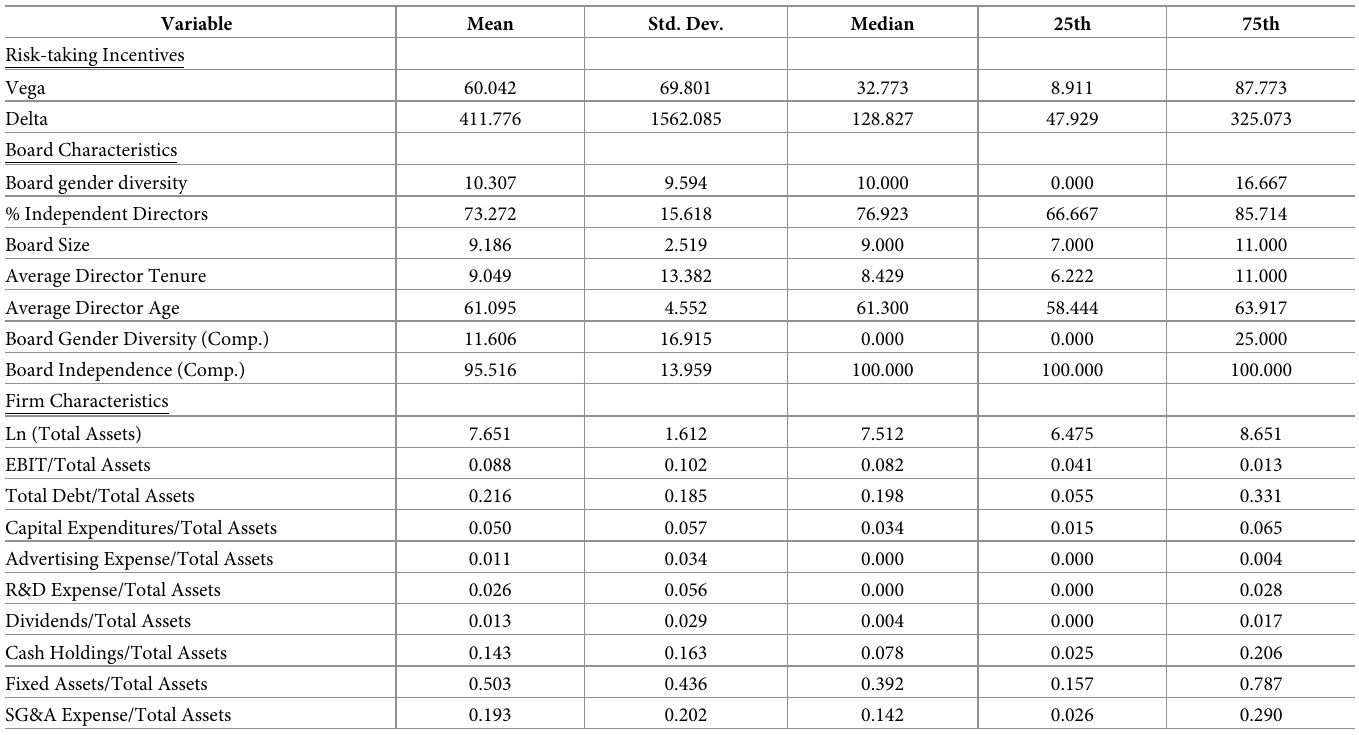
Table 1. Summary